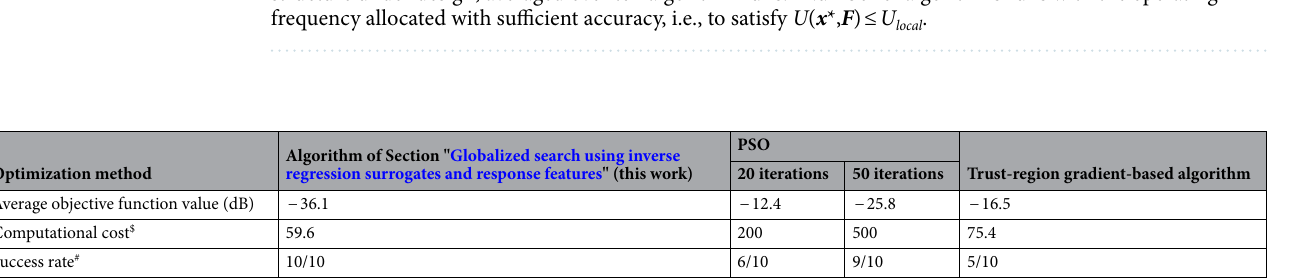
Table 2. Optimization results for Structure I. $ The cost calculated as the number of EM simulations of the structure under design, averaged over ten algorithm runs. # Number of algorithms runs with the operating frequency allocated with sufficient accuracy, i.e., to satisfy U ( x *, F ) ≤ U local .